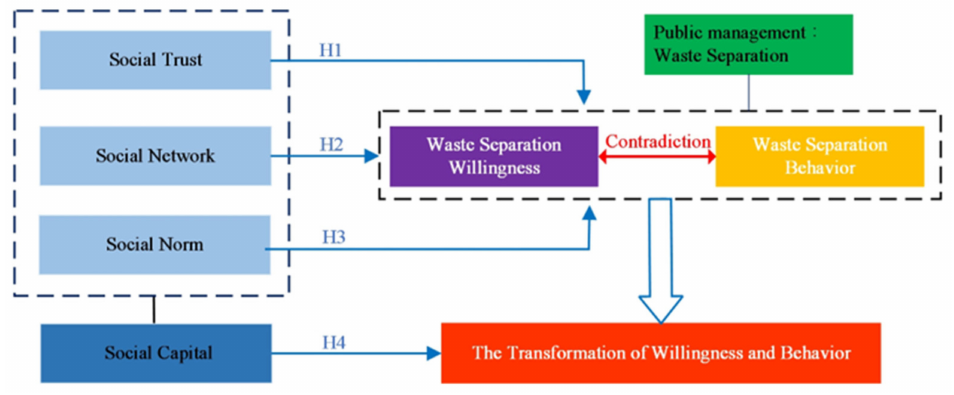
Figure 1. Conceptual